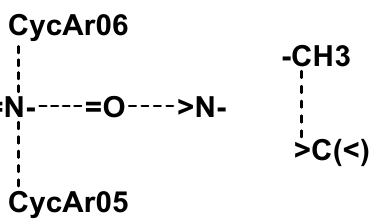
Figure 2. Pharmacophore that defines a high level of FIIa-inhibitory activity of novel compounds .